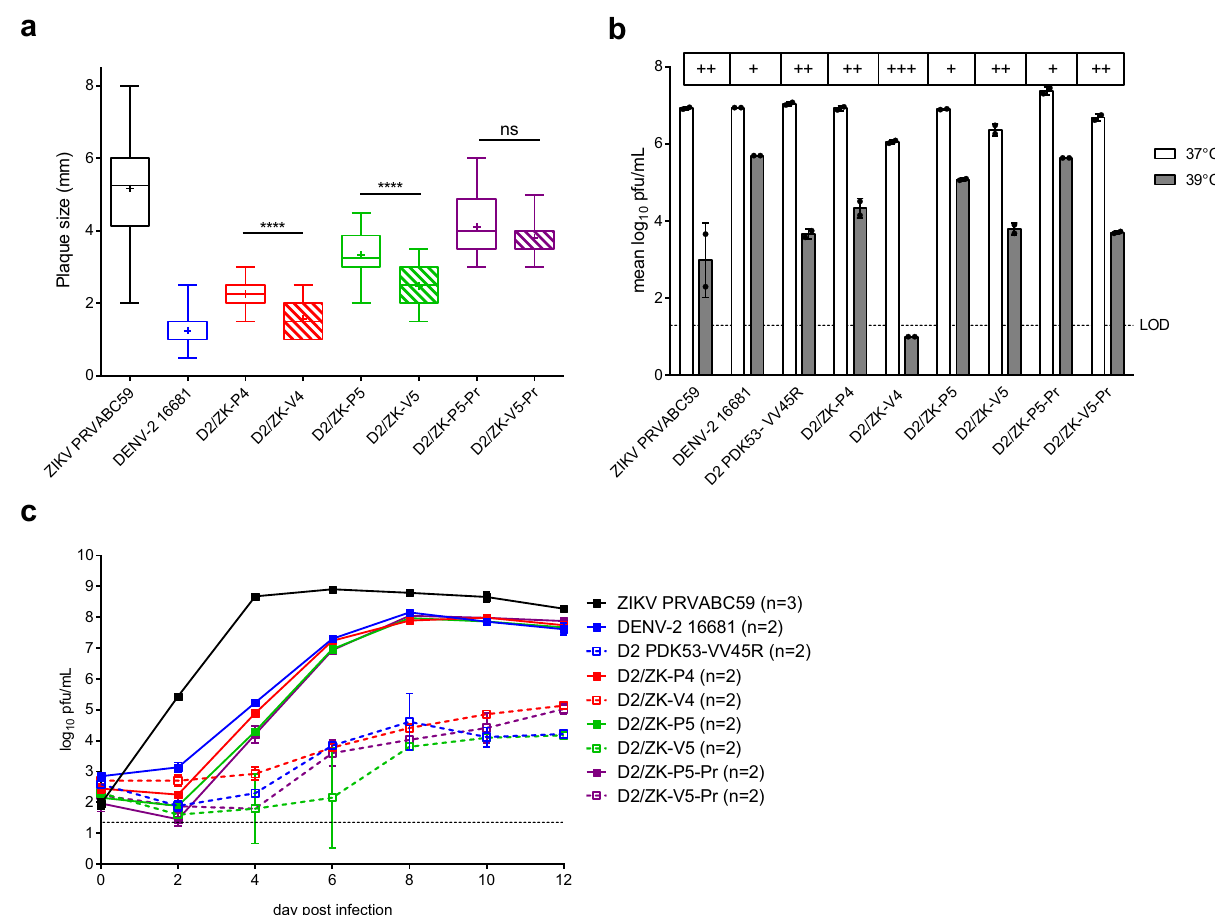
Fig. 3 In vitro attenuation markers of vaccine candidates. a Virus plaque diameter in Vero cells. Box and whiskers plot shows the range of plaque sizes observed for each virus ( n = 12 independent plaques for wt ZIKV; n = 20 plaques for other viruses). The whiskers represent the maximum and minimum diameters, the box is bound by the 25th and 75th percentiles with the median indicated by a solid line and the mean indicated with a cross. A two-tailed, unpaired t test was used to determine statistical differences between P and V viruses. **** p < 0.0001, ns not signi fi cant ( p = 0.1988). b Temperature sensitivity of viruses in LLC-MK2 cells. Peak geometric mean titers (GMTs) with standard deviation (SD) from a growth kinetics study (Supplementary Fig. 1) are shown for each virus. The log 10 differences of peak GMTs between cultures at 37 °C and 39 °C are indicated as + (1 – 2.5 log 10 ), ++ (2.5 – 4 log 10 ) or +++ (>4 log 10 ). Dashed line represents the limit of detection (LOD) of the plaque assay. Black dots show data points from 2 independent cultures ( n = 2). c Growth kinetics of viruses in C6/36 cells: GMTs and SD of each virus group over the time course of the experiment. Number ( n ) of independent cultures conducted is indicated in the symbol legend for each virus. Dashed line represents the LOD of the plaque